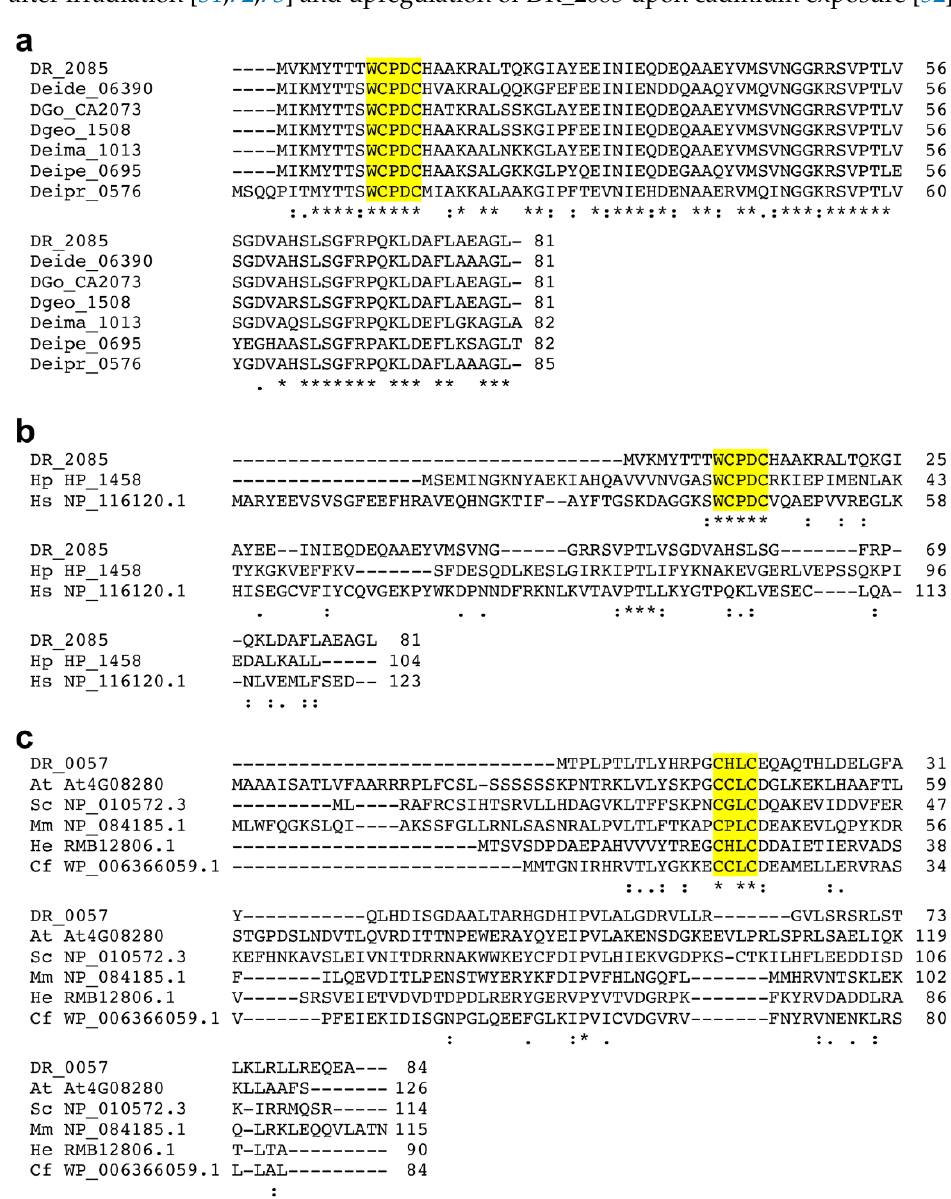
Table 3. Active site motifs in Deinococcus Trx and Trx-like proteins.